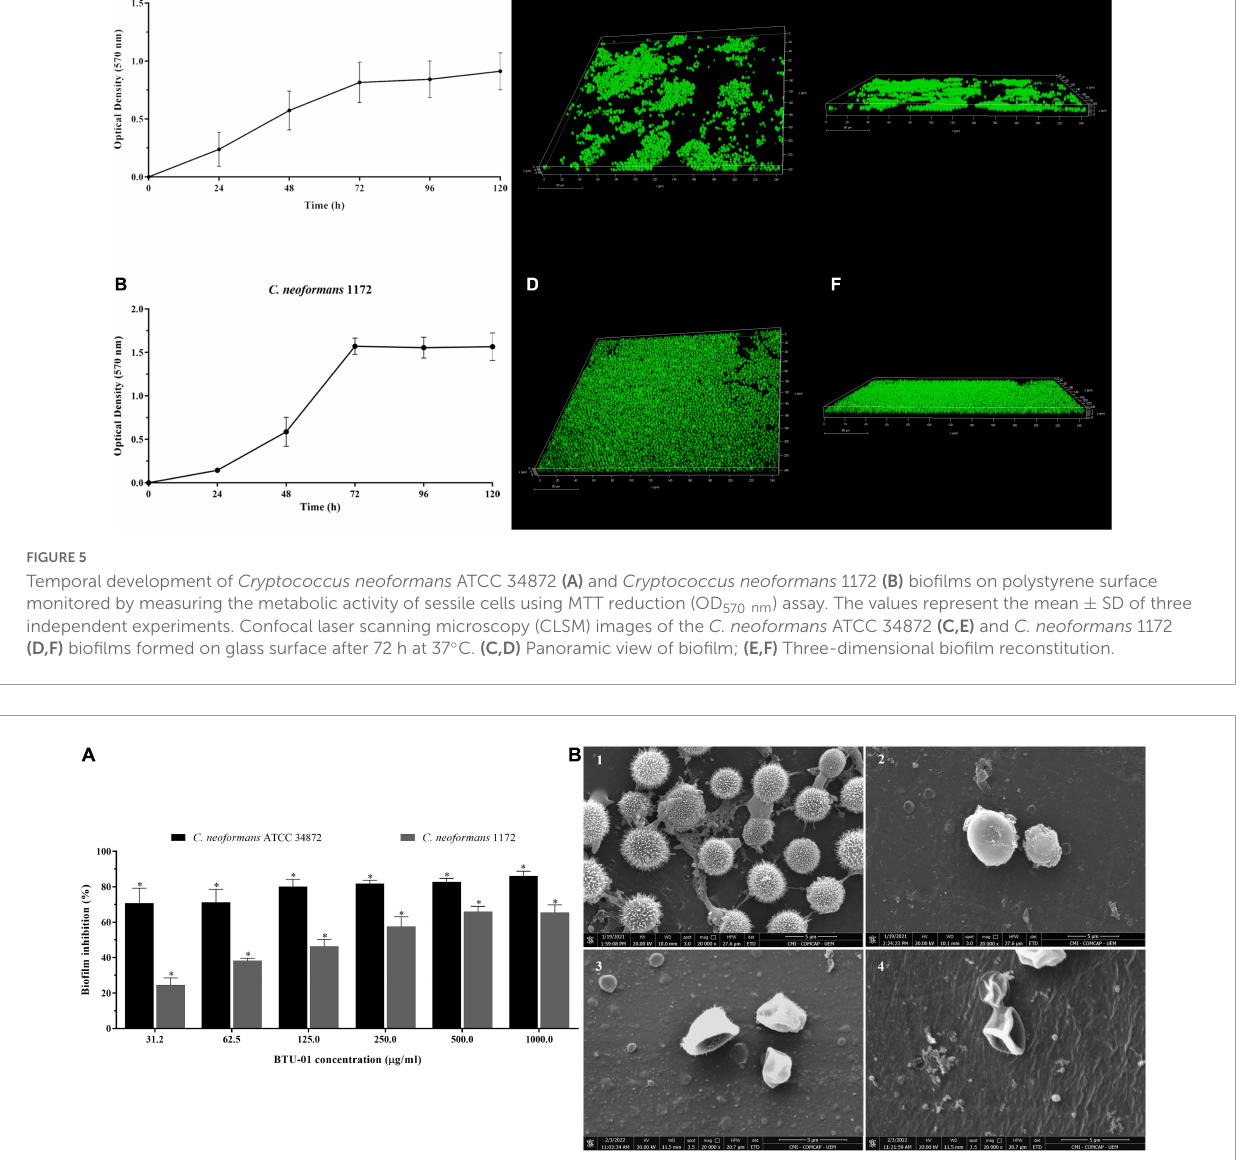
FIGURE6 Antibiofilm activity of N -(butylcarbamothioyl) benzamide (BTU-01) in Cryptococcus neoformans. (A) Percentage of inhibition caused by different concentrations of BTU-01 on 72 h-biofilm of C. neoformans ATCC 34872 and C. neoformans 1172. Metabolic activity of sessile cells was assessed by the MTT reduction method. Values are mean ± standard deviation of three experiments. Asterisks indicate a significant reduction in the metabolic activity of treated sessile cells compared to untreated ones ( ∗ p < 0.05). (B) Scanning electron microscopy images of 72 h-biofilms of C.